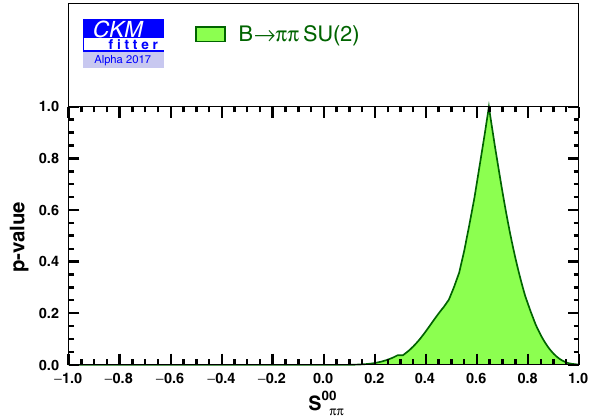
Fig. 28 SU ( 2 ) isospin constraint on the unmeasured time-dependent CP asymmetries in the B 0 → π 0 π 0